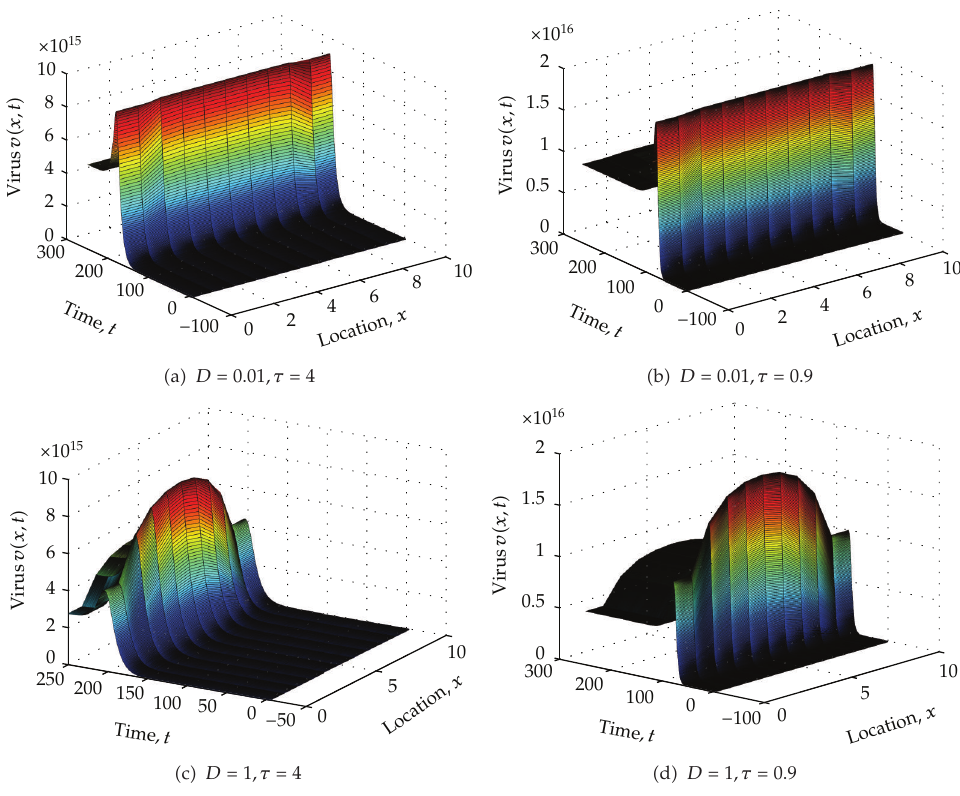
Figure 3: In this case the parameters are L (cid:8) 2 11 , d (cid:8) 3 . 78 − 2 , a (cid:8) 3 . 38 d , p (cid:8) 0 . 67, β (cid:8) 1 . 45 − 4 , k (cid:8) 5 . 18 3 and m (cid:8) 0 .